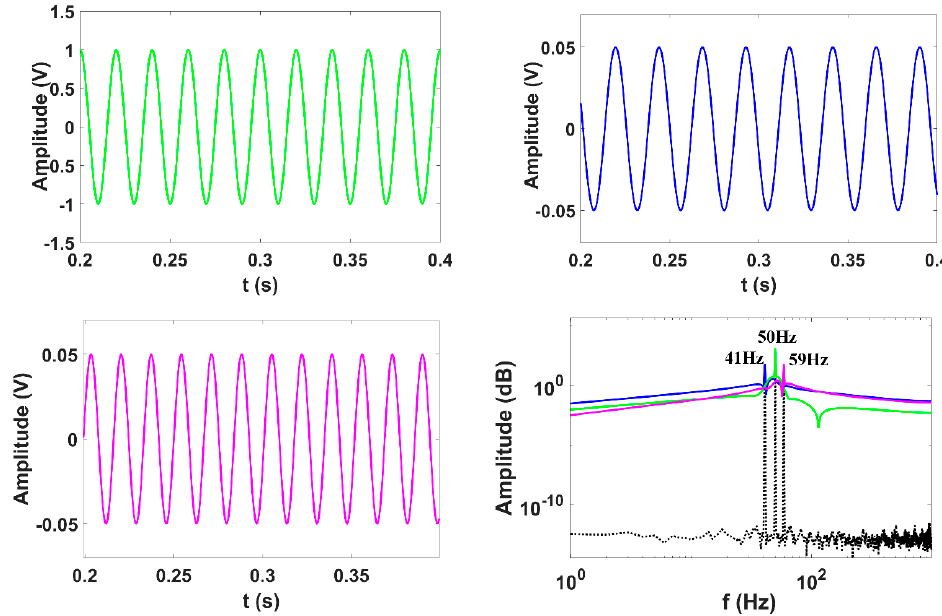
Figure 5. The decomposed modes and their frequency spectrum.